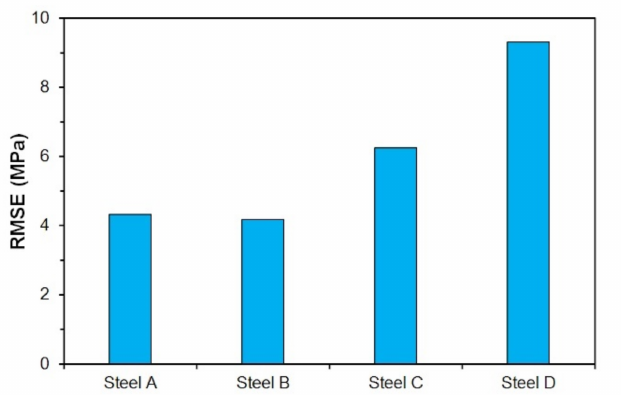
Figure 21. Root mean square error (RMSE) of predicted flow stress curves (by Equation (14)) in range of low strains (from 0 to ε p ) of investigated